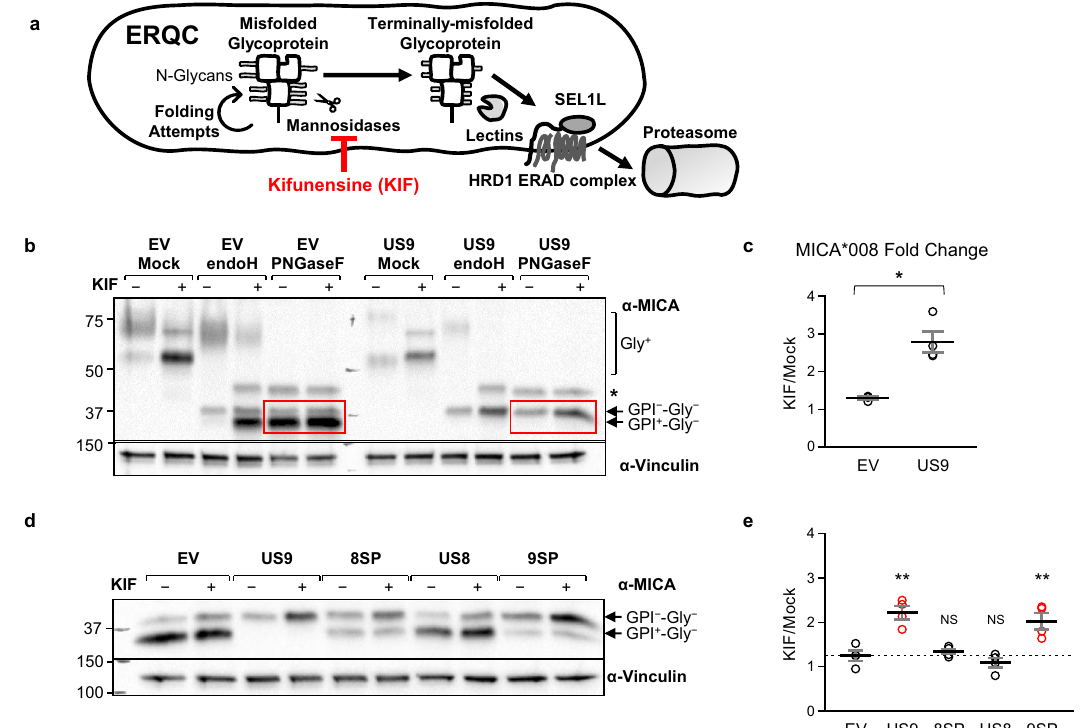
Fig. 9 US9 SP arrests MICA*008 maturation, indirectly leading to ERQC-mediated degradation. a Schematic representation of the effect of kifunensine (KIF) treatment (red line) on the ER quality control (ERQC) pathway. KIF inhibits mannosidases, preventing glycosylation trimming of misfolded glycoproteins and subsequent ER-associated degradation (ERAD). Therefore, KIF treatment should cause the accumulation of untrimmed misfolded glycoproteins. b RKO MICA*008-HA cells expressing EV or US9 were untreated ( − ) or treated ( + ) with 200 µ M KIF and lysed. Lysates were mock- treated (Mock), or digested with endoH or with PNGaseF, and blotted using anti-MICA, with anti-vinculin as loading control. Annotated are the glycosylated forms of MICA*008 (Gly + ), and deglycosylated MICA*008 forms with or without the GPI anchor (GPI + -Gly − and GPI − -Gly − , respectively). * Endogenous MICA*007:01 (42 kDa). Red squares highlight PNGaseF-digested forms used for protein quantitation. c Deglycosylated MICA*008 levels were normalized to the loading control and quanti fi ed relative to the mock EV control. The fold change in levels following KIF treatment was calculated. Data show mean ± SEM for four independent experiments. A two-tailed unequal variance Student ’ s t -test was used to compare the fold change in EV vs. US9-expressing cells ( p = 0.011). * p < 0.05. d The indicated cells were untreated ( − ) or treated ( + ) with KIF as described. Lysates were obtained,